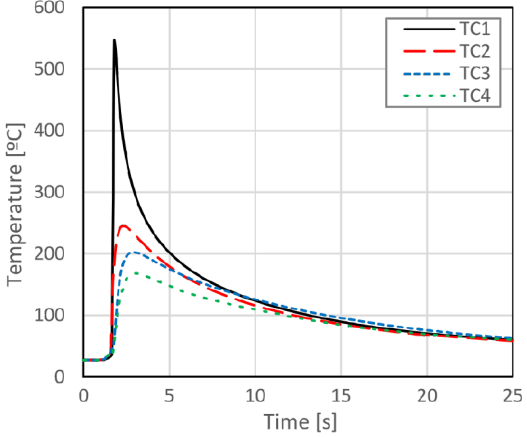
Figure 3. Experimental temperature records during welding.